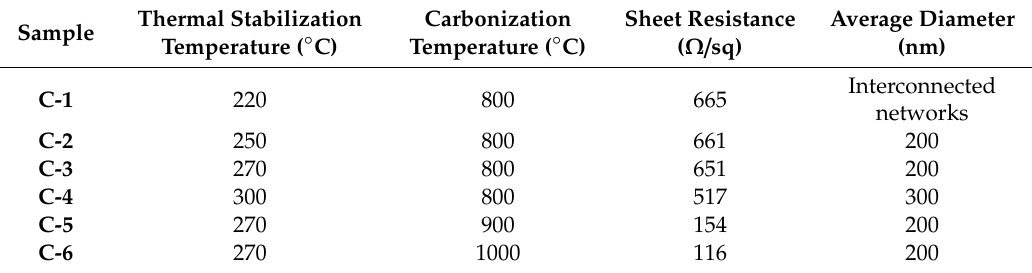
Table 1. Sheet resistance and average diameter of the PAN-derived carbon nanofibers with 12 wt% PAN treated at various thermal stabilization and carbonization